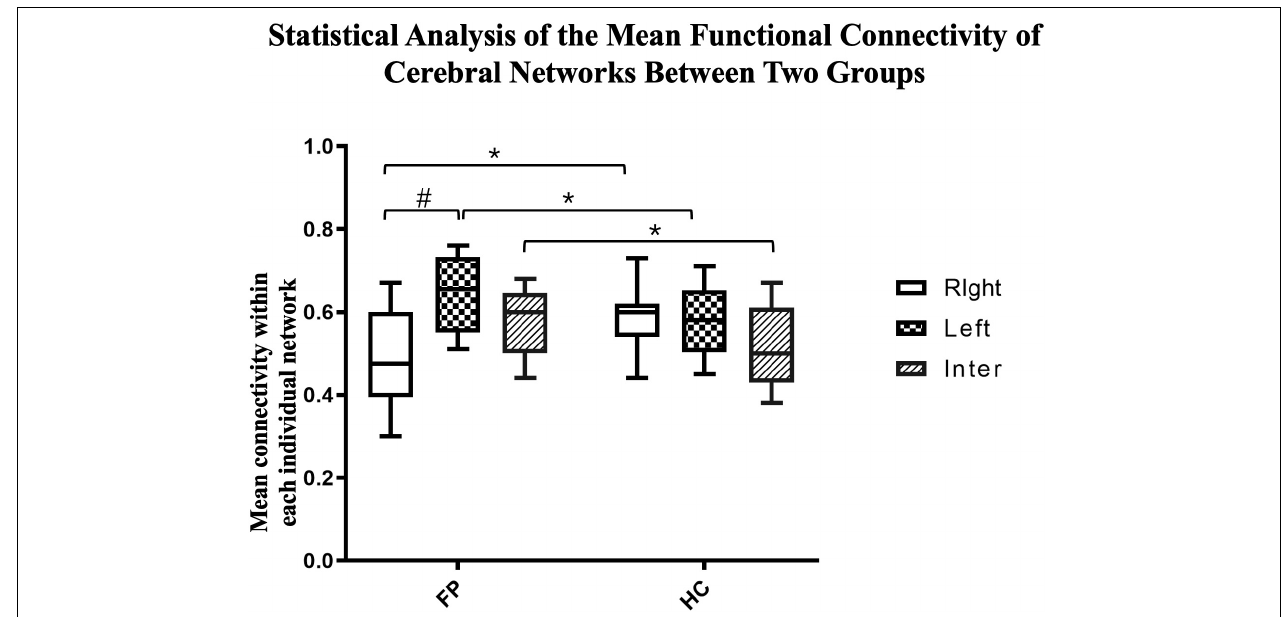
FIGURE 5 | Statistical analysis of the mean functional connectivity of cerebral networks between the two groups. The mean functional connectivity in the left, right, and inter-hemispheric networks of patients ( n = 22) and controls ( n = 15) are shown. These network-specific averaged z-score values ( via Fisher’s z-transformation) were then tested for differences both within and between groups. * p < 0.05 between groups; # p < 0.05 within groups; paired t -test.